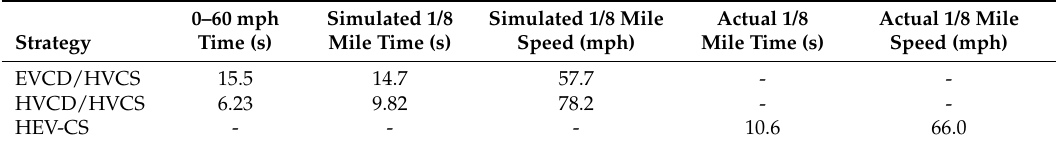
Table 12. Acceleration performance under EVCD/HVCS and HVCD/HVCS control strategies, and actual Explorer recorded data under HEV-CS strategy [58].